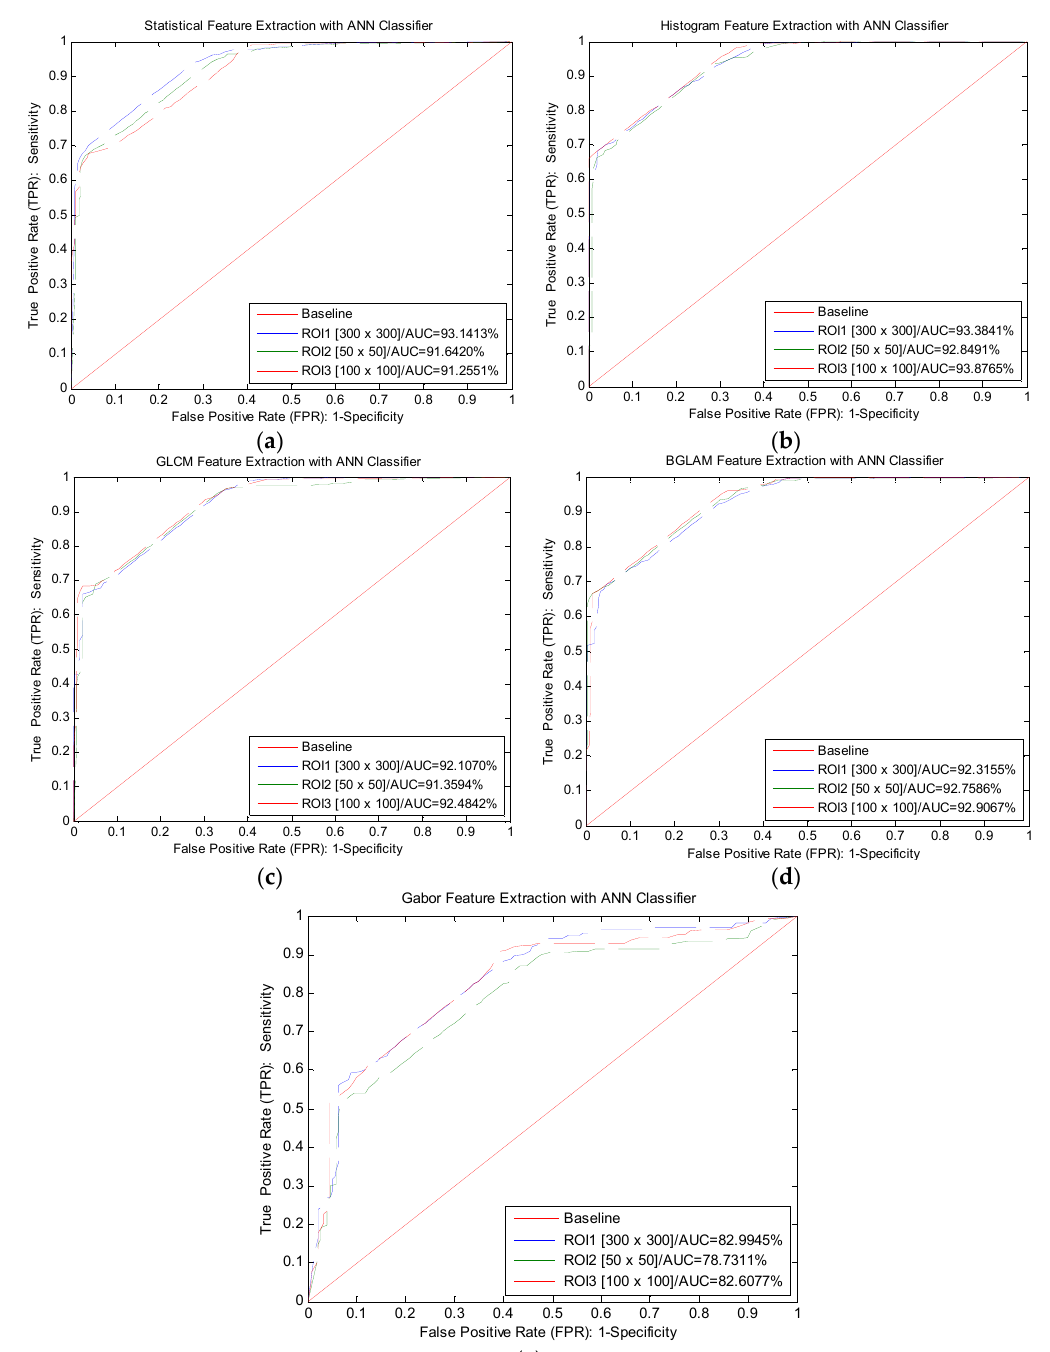
Figure 13. AUC score of FFB maturity based on feature extraction and ANN: ( a ) statistical, ( b ) histogram, ( c ) GLCM, ( d ) BGLAM and ( e ) Gabor. Table 3 indicates that the MLP and MSE learning stage of the learning procedures did not exceed 0.003. The higher proficiency score observed revealed a selection scale of the architectural MLP model [40 × 30 × 1], [25 × 10 × 1], [40 × 30 × 1], [45 × 22 × 1] and [40 × 20 × 1] over all the tracks with statistical color function, color histogram, GLCM, BGLAM and GW, respectively, for the FFB recording system. After several training